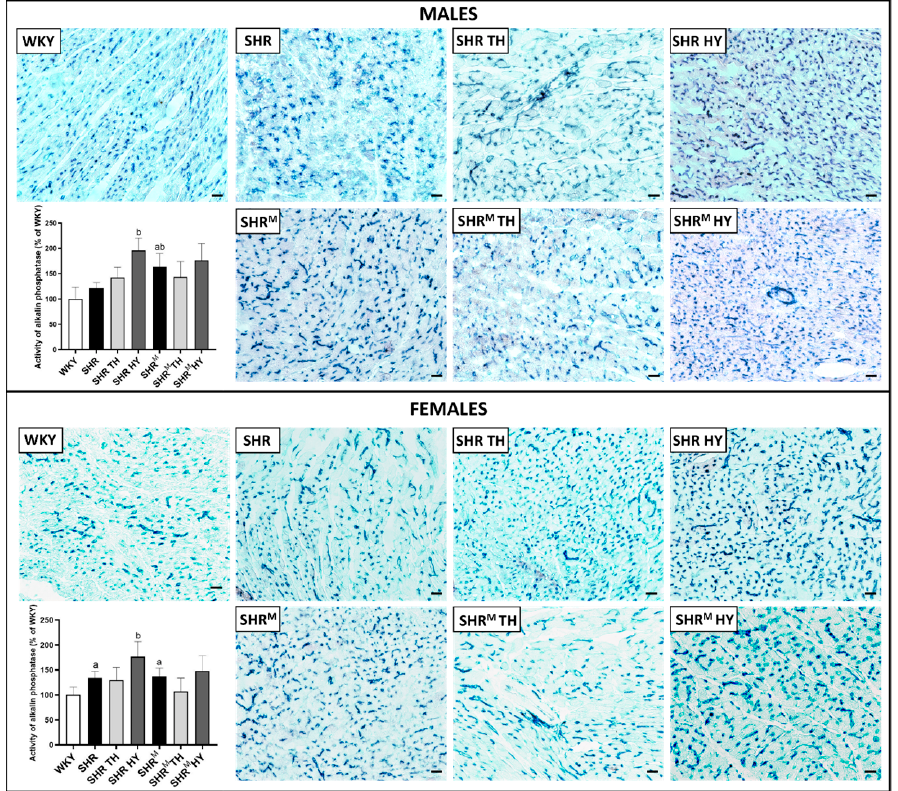
Figure 3. Histochemical demonstration of the alkaline phosphatase (AP) activity (blue) in endothelial cells of the arterial portion of capillaries and quantification of the intensity of the reaction. Note the enhanced AP activity in SHR M males compared to the wild type strain, as well as in response to the hypothyroid status. WKY—Wistar Kyoto normotensive control rats, SHR—wild type spontaneously hypertensive rats, TH—hyperthyroid rats, HY—hypothyroid rats and SHR M —hairless spontaneously hypertensive rats, n = 5 per group. Scale bar represents 200 µ m. Data are presented as means ± SD, a p < 0.05 vs. WKY and b p < 0.05 vs. SHR. One-way ANOVA and Bonferroni’s multiple comparison test were used as the statistical method.